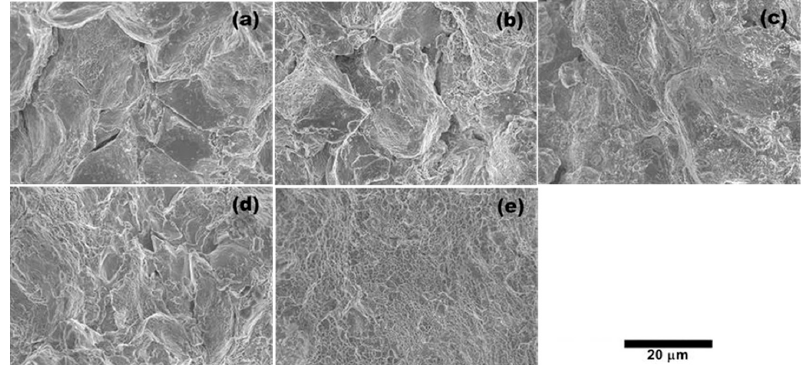
Figure 4. SEM images of fracture surfaces of cold sprayed Inconel 718 deposits: ( a ) as-sprayed and ( b – e ) heat treated at ( b ) 950 °C/2 h, ( c ) 1010 °C/2 h, ( d ) 1060 °C/2 h, and ( e ) 1250 °C/1 h. The almost completely dimple rupture in ( e ) was ascribed to improved metallurgical bonding and plastic deformation (adapted from reference [39] , with permission from © Springer Nature).